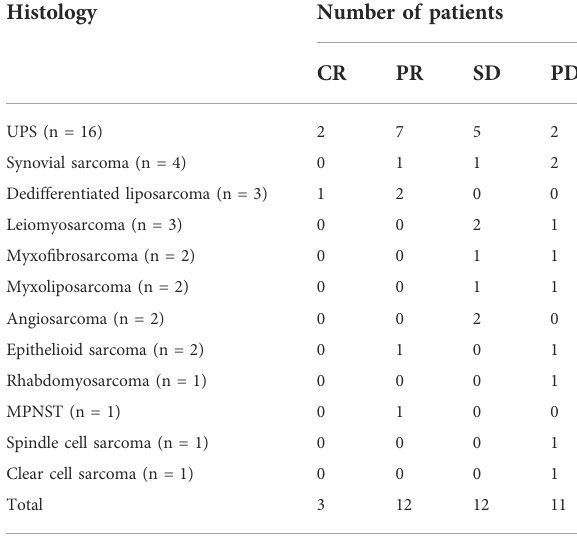
TABLE 1 Clinical characteristics of enrolled patients. TABLE 2 Best responses of various histologicalsubtypes to